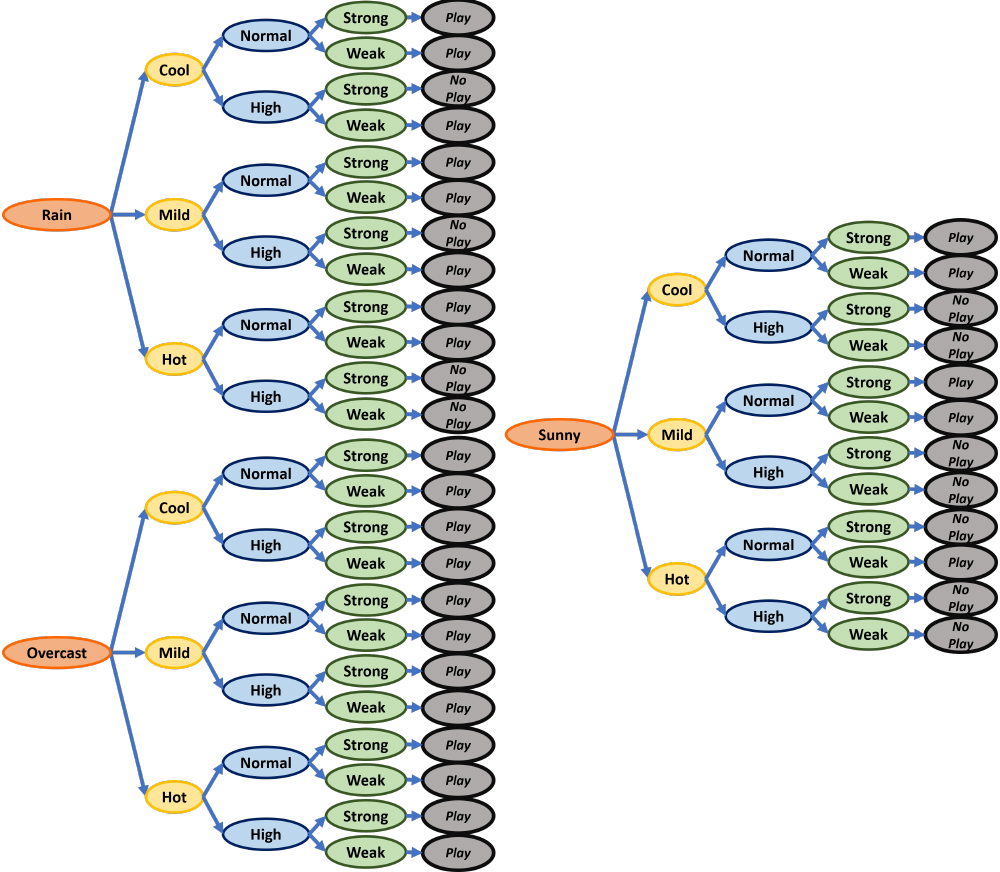
Figure 10. The classifier’s test problem: Naive Bayes decision